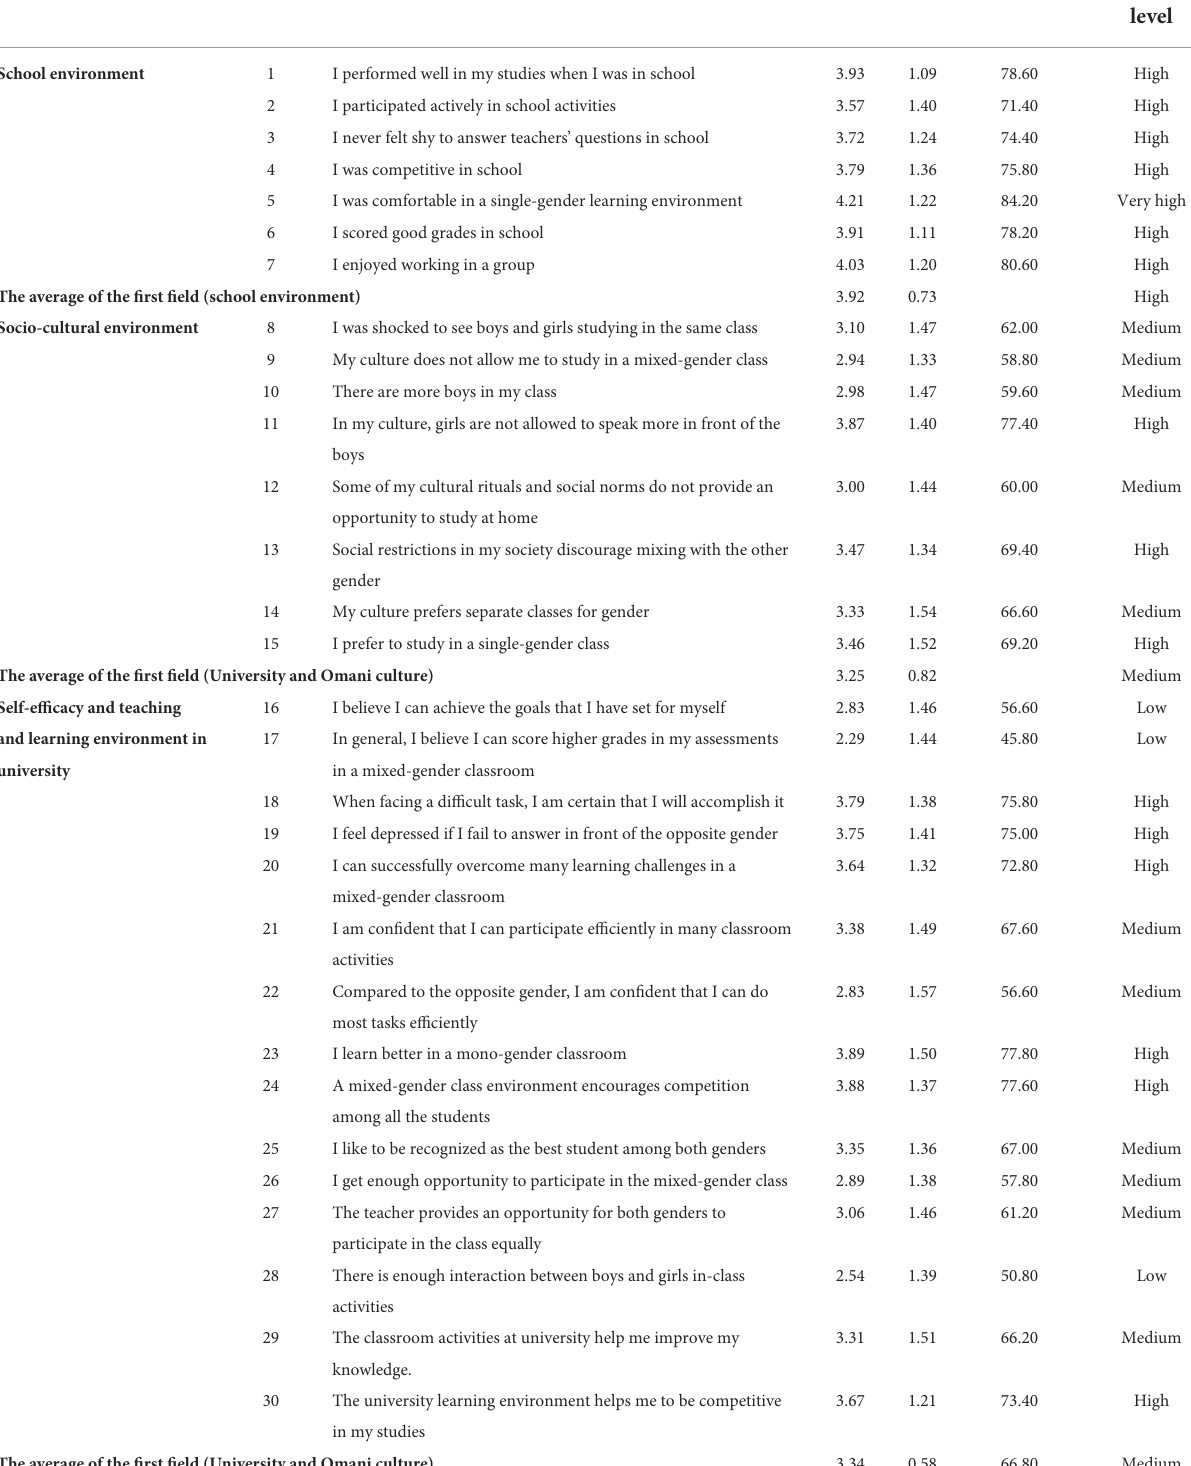
TABLE 1 Responses of the study sample to the areas of the questionnaire in all its items. Area S.